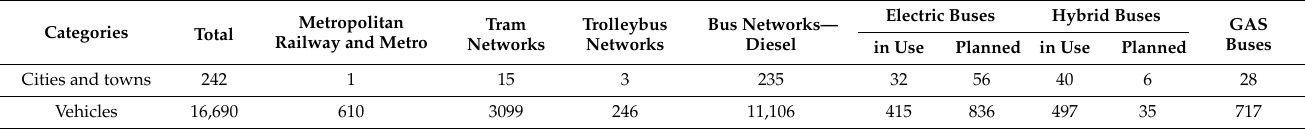
Table 2. The number of cities and towns and the number of urban public transport vehicles.